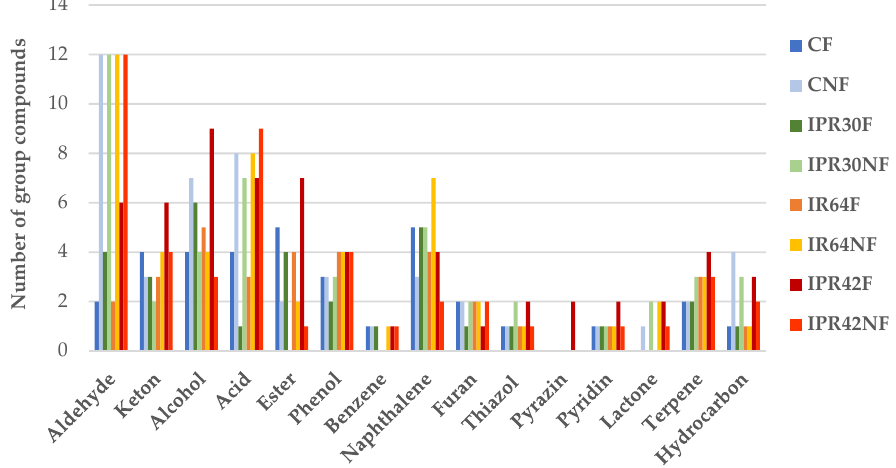
Figure 1. Number of volatile compounds in Ciherang fermented (CF), Inpari42 fermented (IPR42F), Inpari30 fermented (IPR30F), IR64 fermented (IR64F) Ciherang nonfermented (CNF), Inpari42 nonfermented (IPR42NF), Inpari30 nonfermented (IPR30NF) and IR64 nonfermented (IR64NF) rice bran.